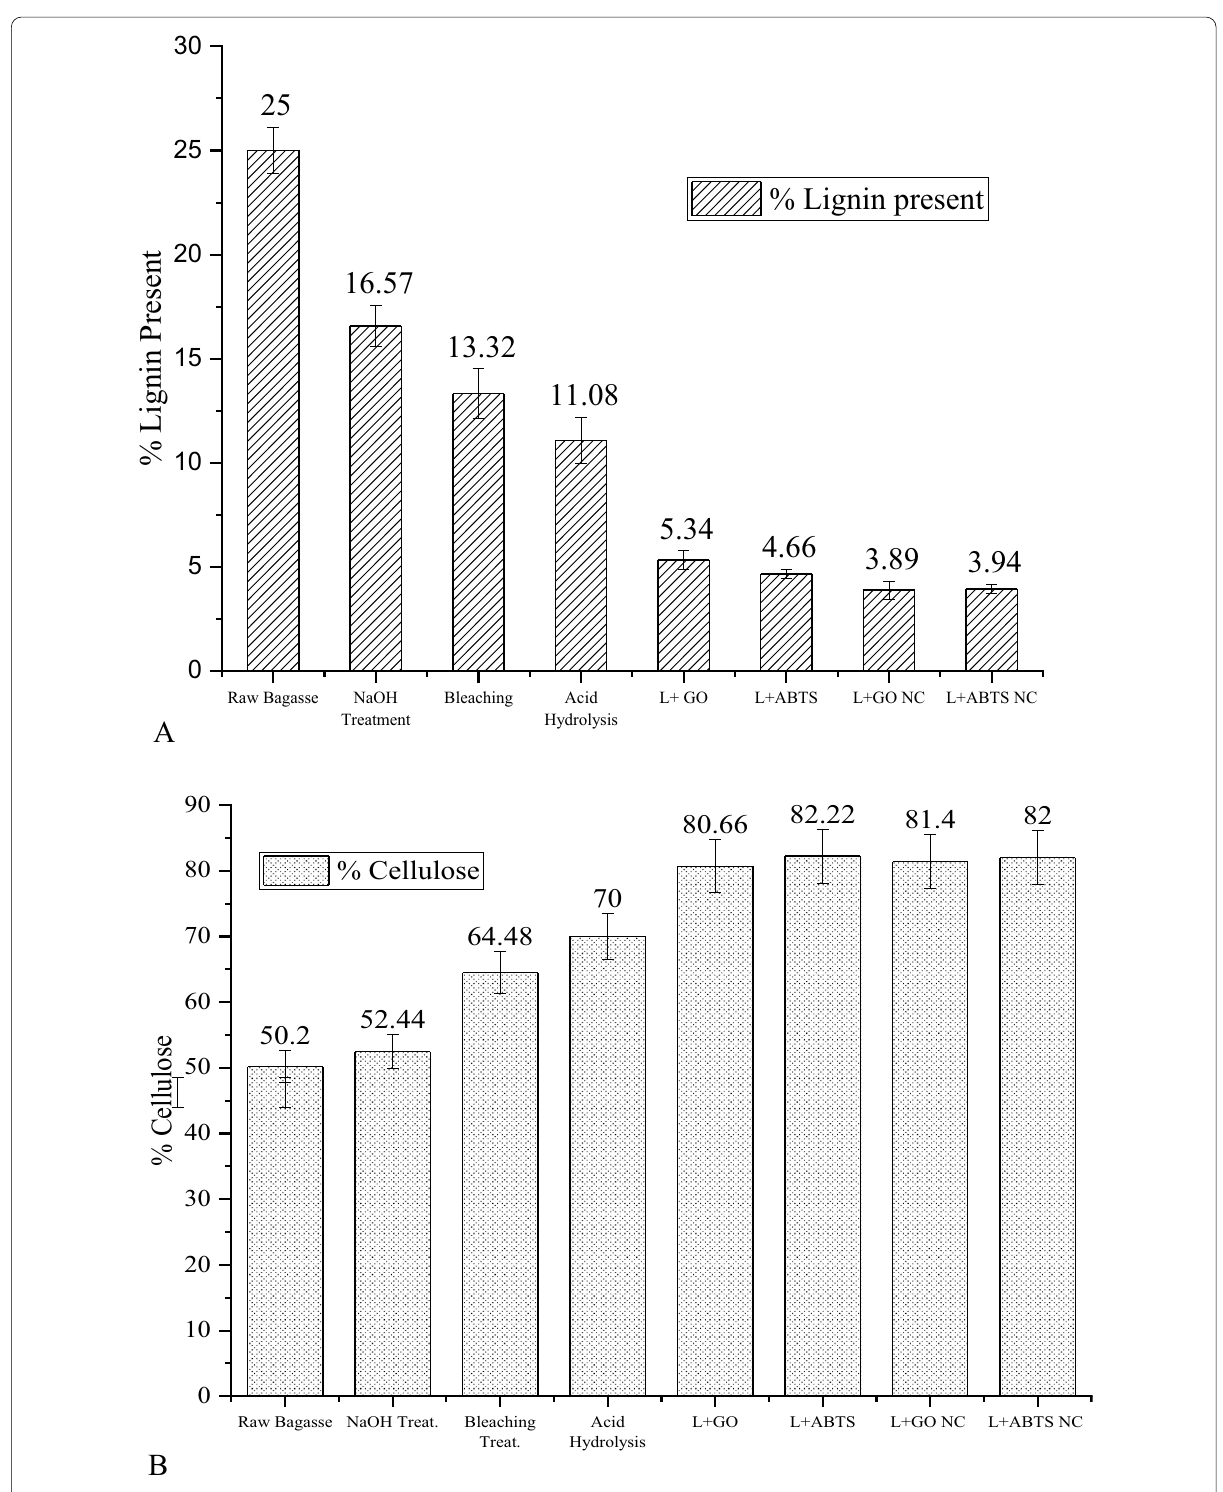
Fig. 5 A Lignin percentage present after each treatment process. B Cellulose percentage after each treatment